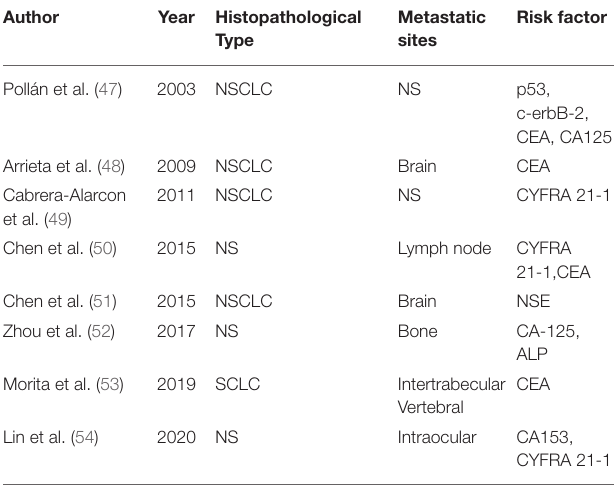
TABLE 5 | Tumor markers for metastatic lung cancer